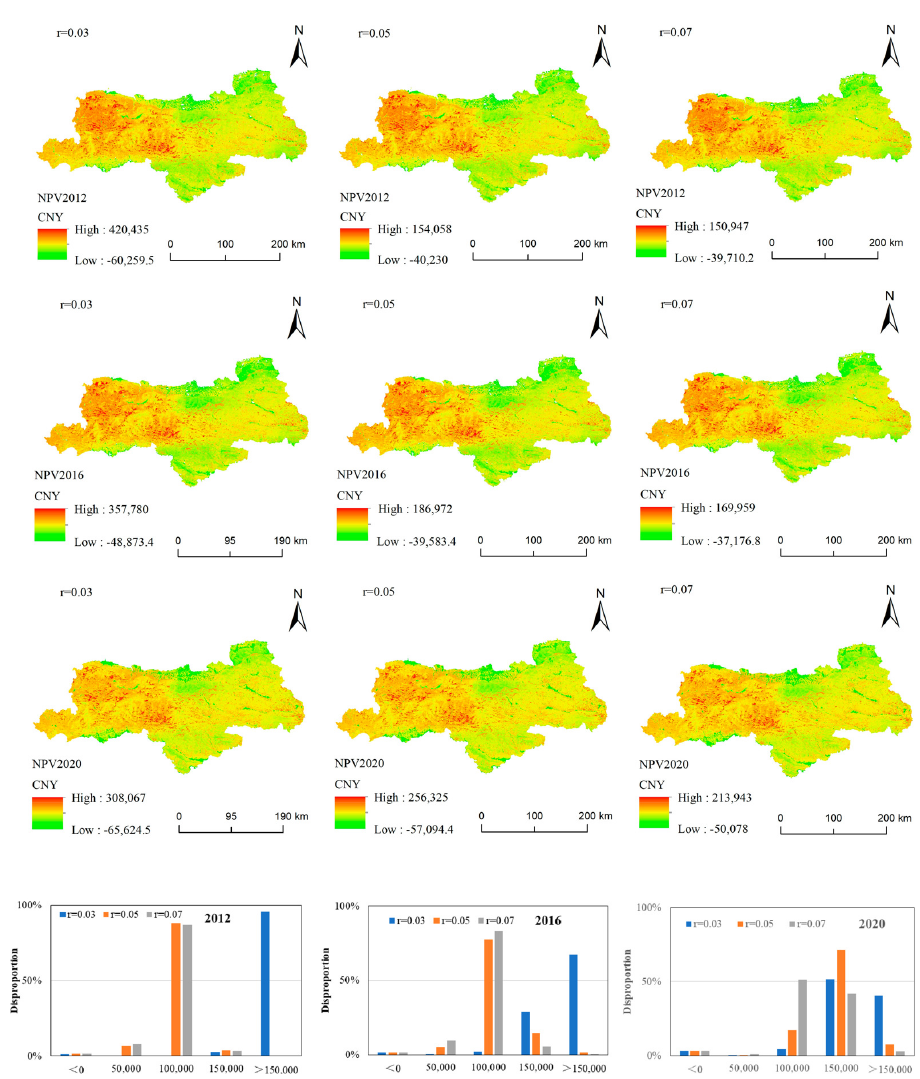
Figure 8. Spatial distribution of carbon sink value and grading proportion in Qinling Mountains